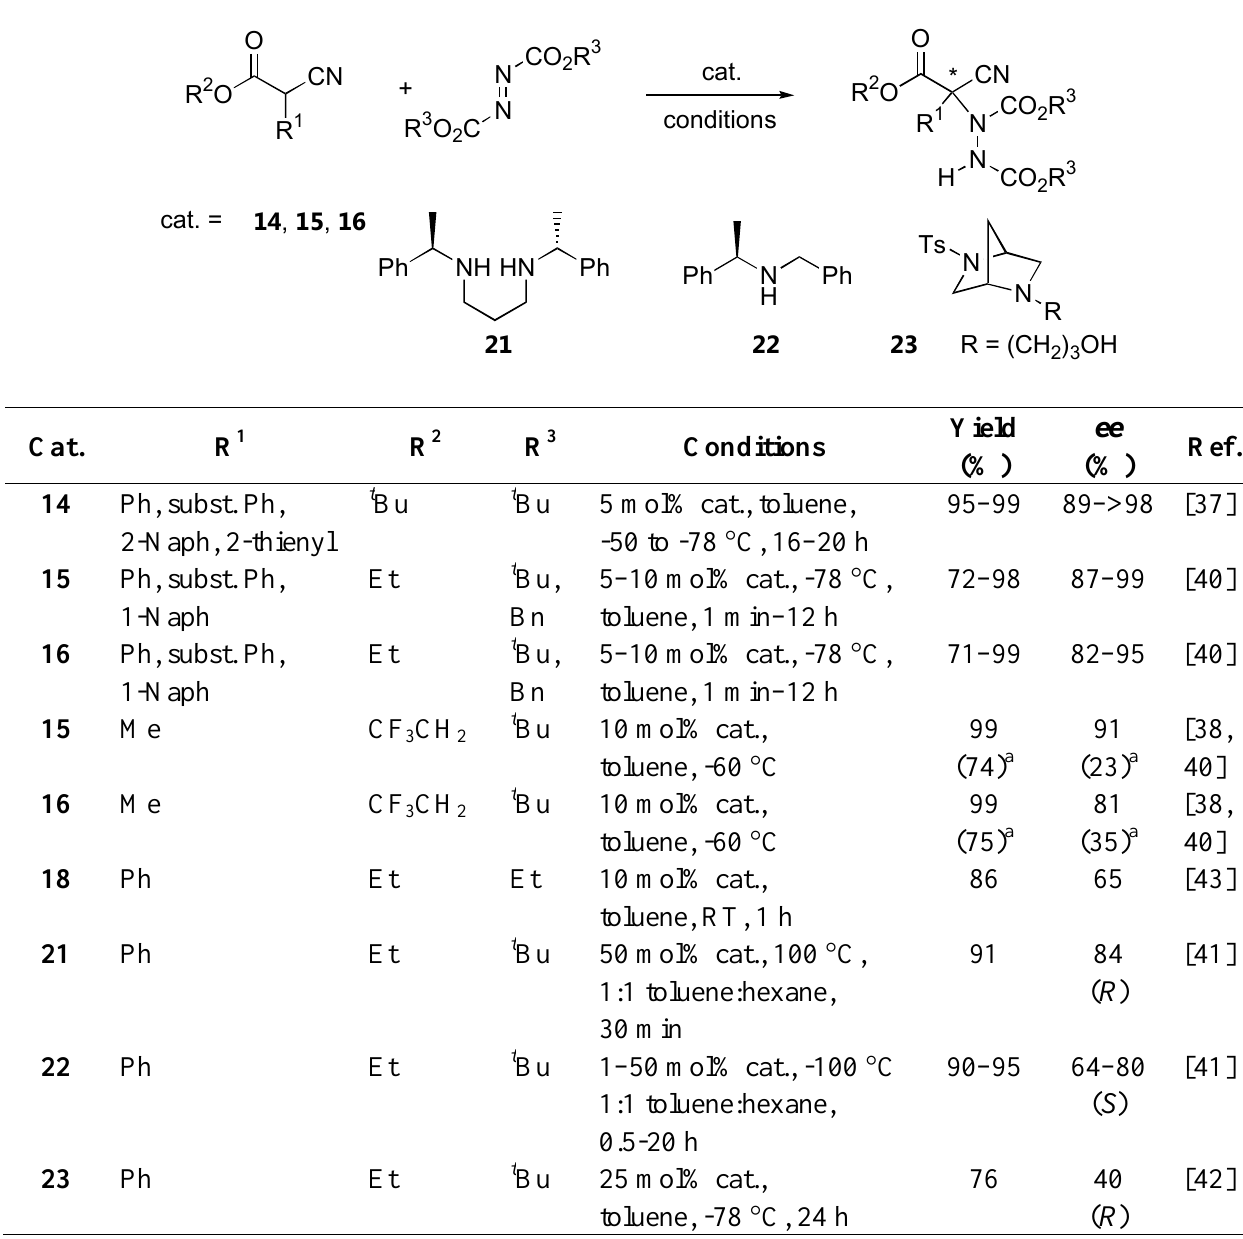
Table 5. Direct  -amination of  -substituted 